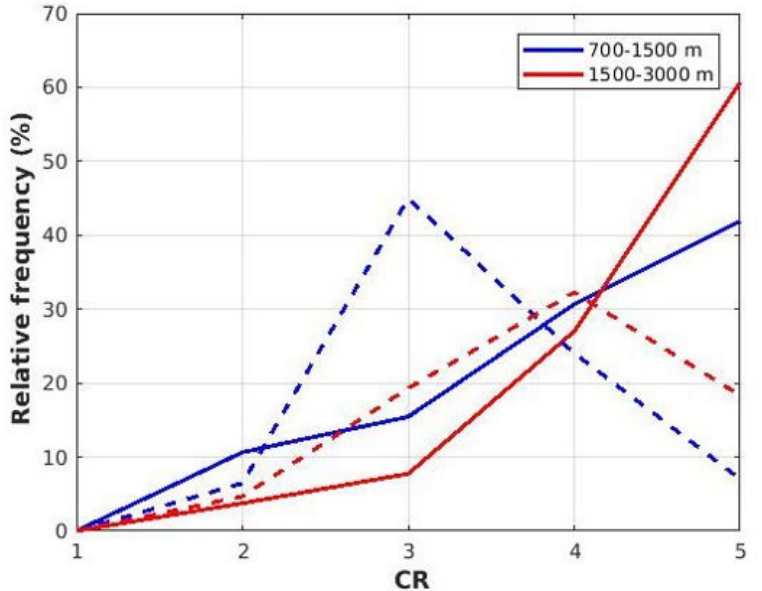
Figure 16. Comparing the colour ratios from 1 to 13 of March 2018 (Müller [45]) in comparison to the data from this study (all available data from March 2019). The filled lines (in italic ) represent the 2018 data, while the dashed lines represent the 2019 data (this